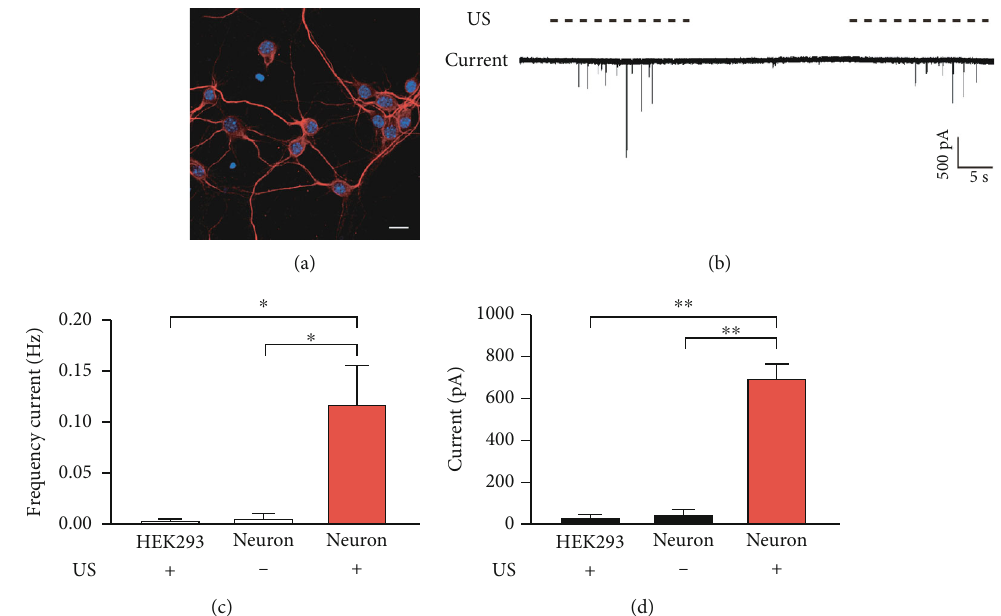
Figure 2: Ultrasound stimulation induces inward current in cultured cortical neurons. (a) A representative confocal image shows the immuno fl uorescence of MAP2 (red), a marker of mature neurons, of the cultured neurons after 14 days in vitro . The nuclei were labeled by DAPI (blue). Bar = 20 μ m . (b) The membrane current recording of a representative neuron in response to US stimuli. The dashed lines show the stimulation of US pulses. (c, d) The mean frequency (c) and amplitude (d) of inward current of neurons with or without US stimulation. The response of HEK293 cells is compared as the control. Data are presented as the mean ± SE . ∗ p < 0 : 05 ; ∗∗ p < 0 : 01 ; n = 6 for each group, one-way ANOVA.